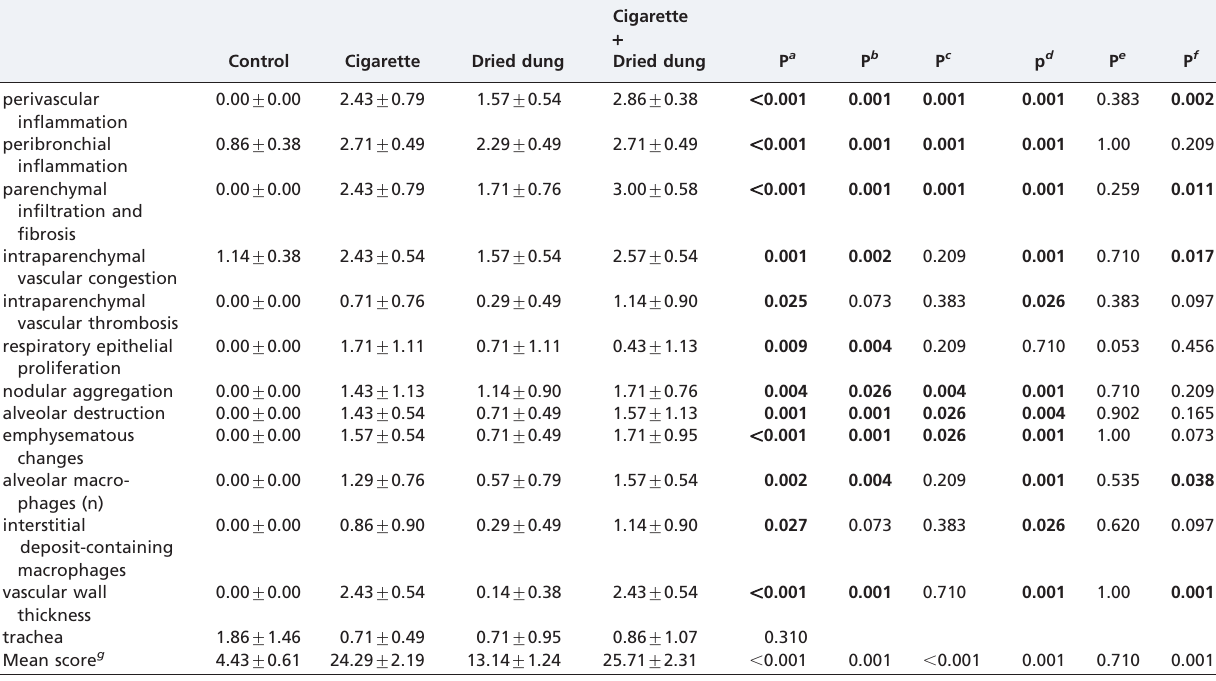
a Comparison among four groups (Kruskal-Wallis test). b Comparison between control and cigarette groups (Mann-Whitney U test). c Comparison between control and dried dung groups (Mann-Whitney U test). d Comparison between control and cigarette + dried dung groups (Mann-Whitney U test). e Comparison between cigarette and cigarette + dried dung groups (Mann-Whitney U test). f Comparison between dried dung and cigarette + dried dung (Mann-Whitney U test). g Changes of each histopathological parameters were scored from 0 to 4, then summed for a maximum total score of 42. Data are shown as mean ¡ SEM.